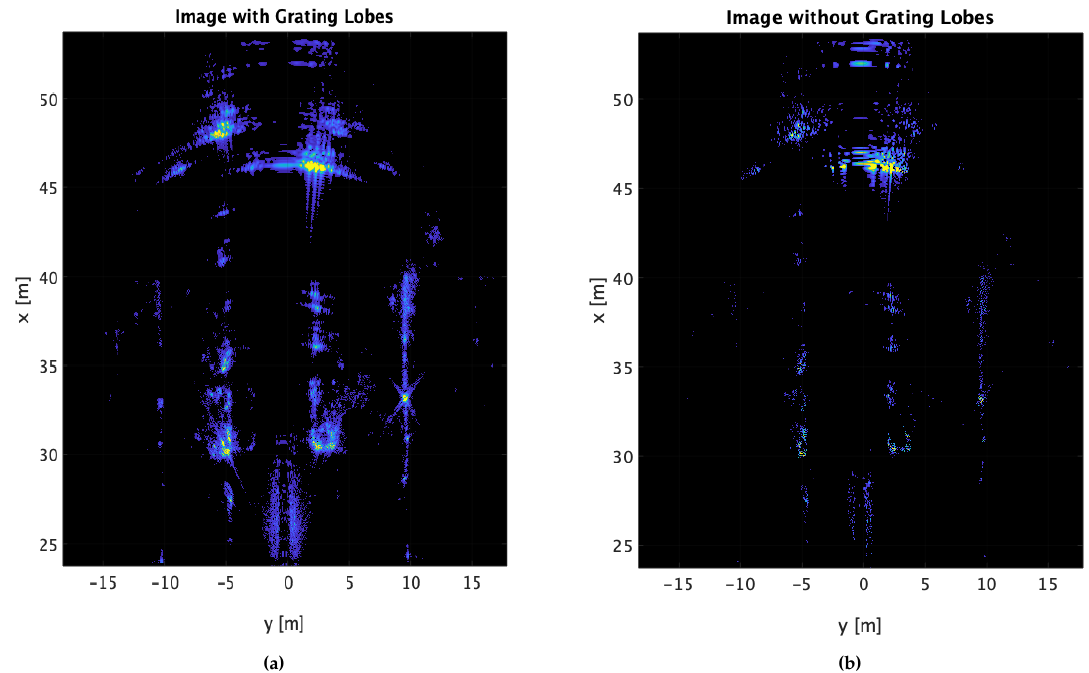
Figure 9. (a): Image geocoded into the Cartesian reference system. (b): Image geocoded into the Cartesian reference system without the grating lobes. Figure 8. ( a ): Image geocoded into the Cartesian reference system. ( b ): Image geocoded into the Cartesian reference system without the grating